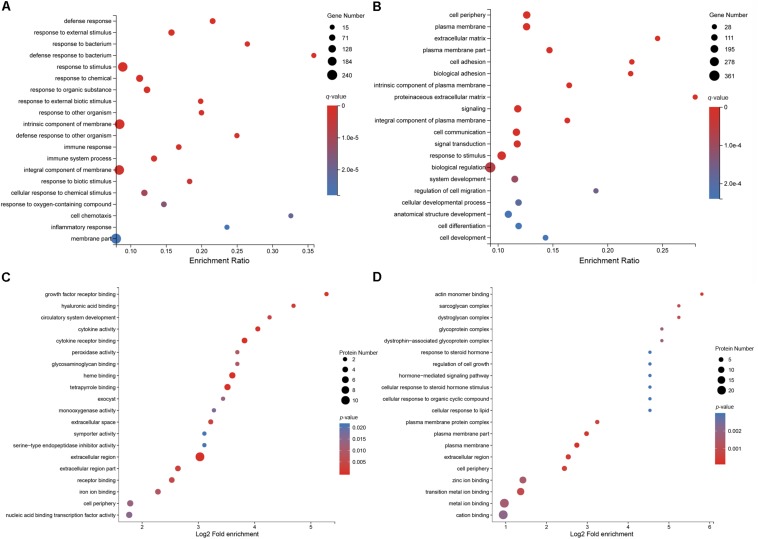
GO enrichment analysis of DEGs and DEPs in MS-treated CSF. Statistics of the top 20 enriched GO term for upregulated DEGs (A), the top 20 enriched GO term for downregulated DEGs (B), the top 20 enriched GO term for upregulated DEPs (C), and the top 20 enriched GO term for downregulated DEPs (D).